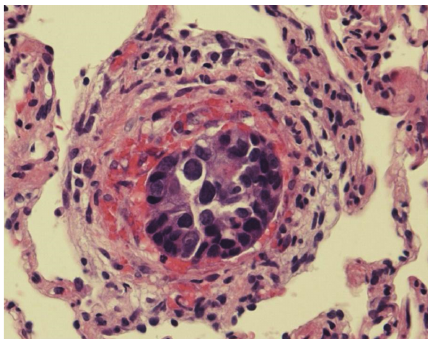
Figure 3: Obstruction of the pulmonary artery and endothelial fibrocystic hyperplasia was determined by transbronchial lung biopsy specimens from the lower lobe of the right lung (hematoxylin and eosin staining, ×